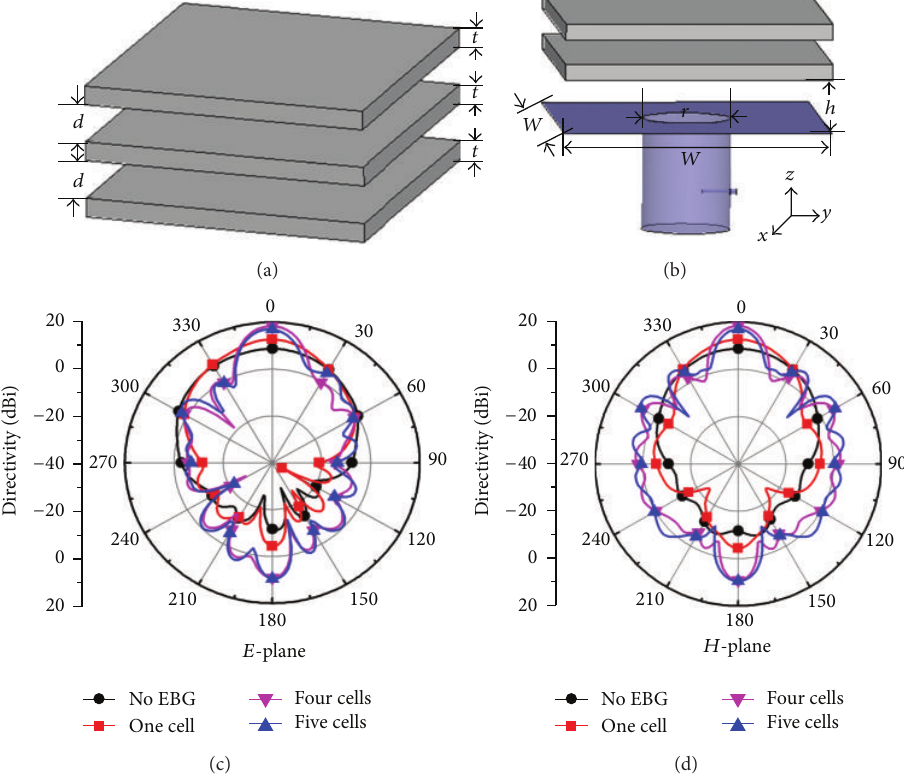
Figure 2: (a) Dielectric EBG structure, (b) circular waveguide antenna with EBG superstrate, (c) radiation patterns of 𝐸 -plane with different EBG cells, (d) radiation patterns of 𝐻 -plane with different EBG